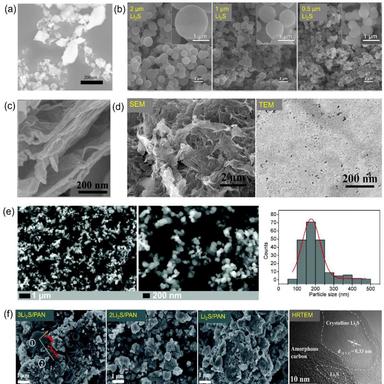
(a) The SEM images of Li2S via using LiEt3BH and sulfur as reactants without auxiliary solvents. (b) Li2S with different amount of toluene as auxiliary solvent . (c) In-situ generated TG-Li2S composite . (d) The SEM and TEM images of in-situ nano-Li2S/GA composites after lithiation. (e) Morphology and particle size distributions based on SEM of Li2S prepared from 0.15 M sulfur solutions via microwave synthesis. (f) SEM images of the 3Li2S/